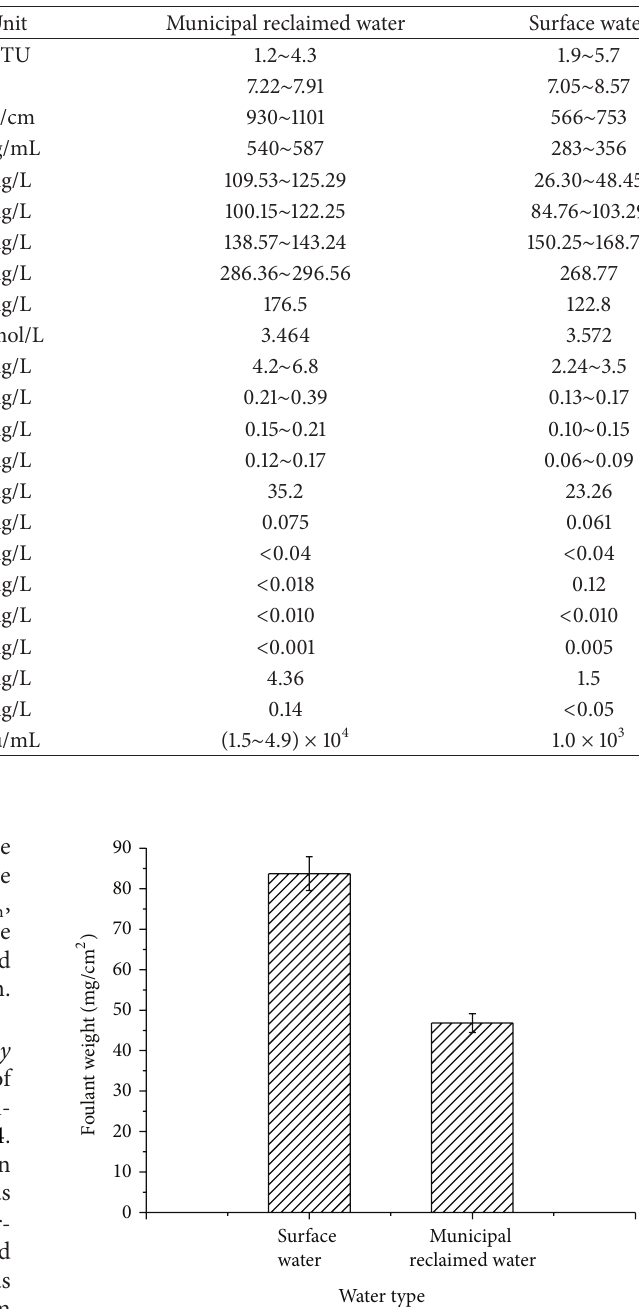
Table 2: Comparison of water quality of municipal reclaimed water and surface water.